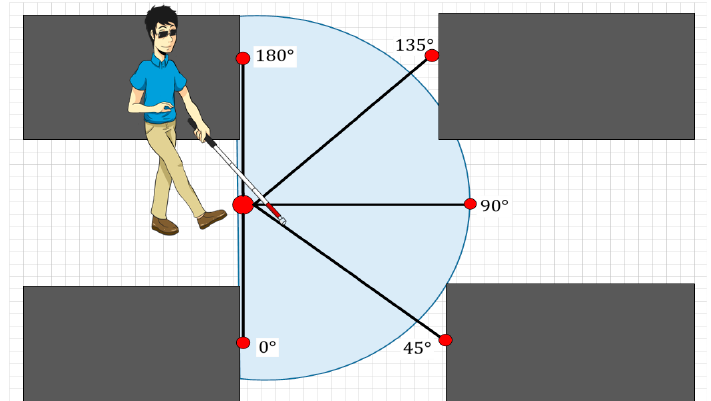
Figure 9. Spatial recognition of the area around the user.